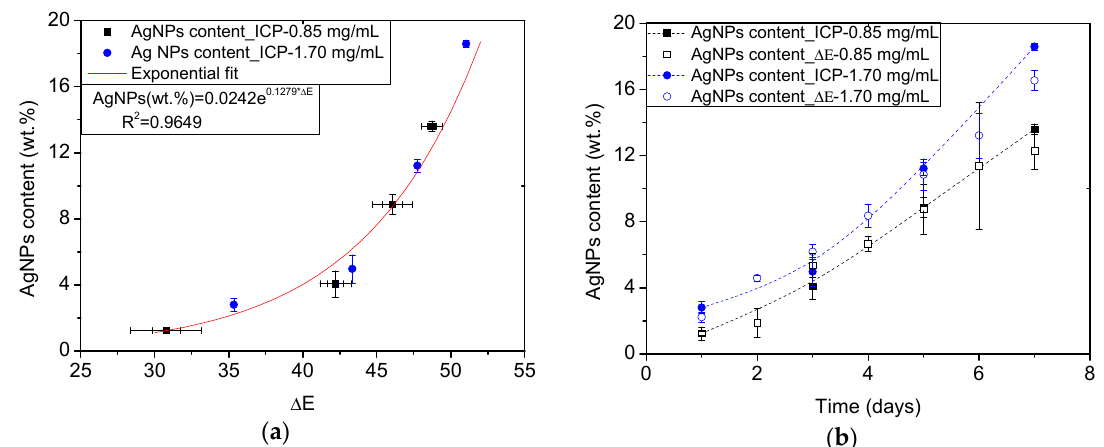
Figure 6. Calibration curve relating the AgNPs content (wt.%) reference values obtained by ICP-OES [10] and the Δ E* ab measured on the ME/Ag foams. The obtained calibration equation is shown in an inset ( a ). AgNPs content (wt.%) of all ME/Ag foams calculated from the measured Δ E* ab and using the previous calibration. Trends of the reference values from ICP-OES measurements are shown in dotted lines for comparison purposes ( b ).